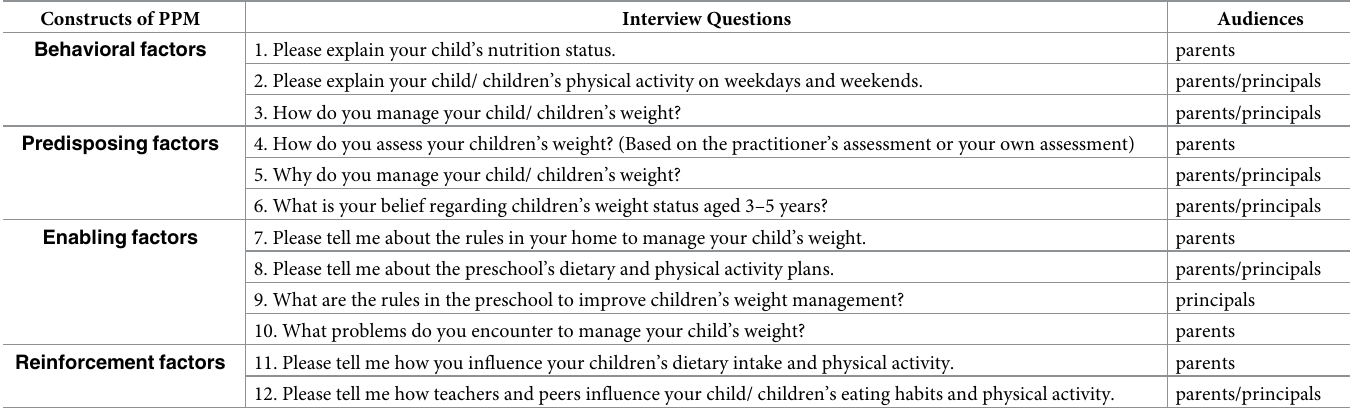
Table 3. Interview